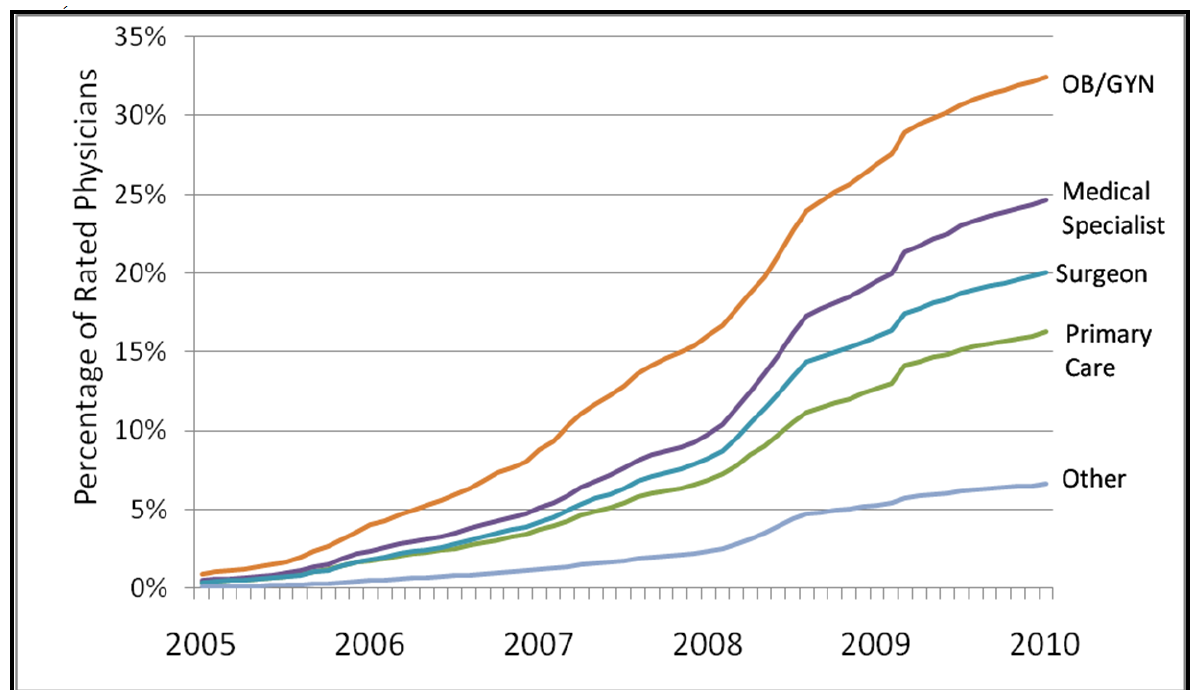
Figure 2. Percentage of US physicians rated in each specialty (based on data from RateMDs.com and the US Department of Health and Human Services’ Area Resource File). OB/GYN =